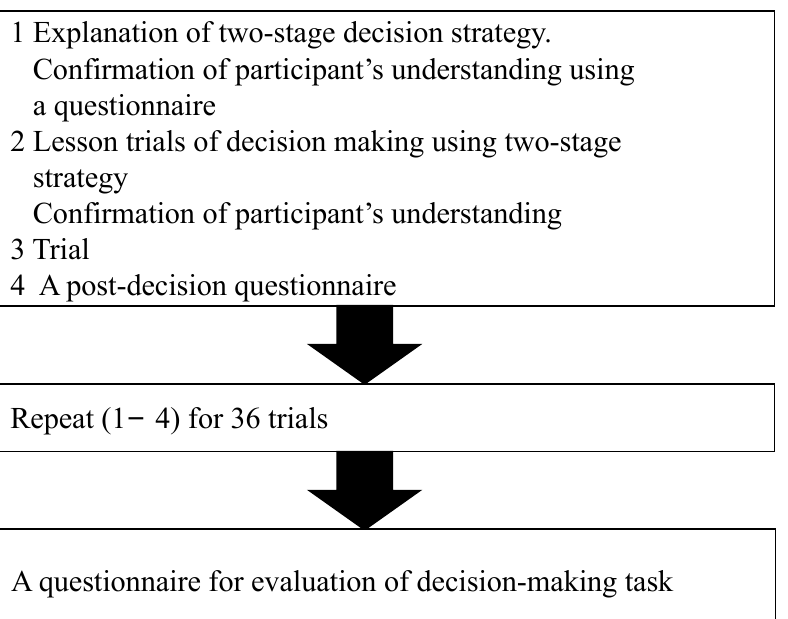
Figure A22. General flow of the experiment.